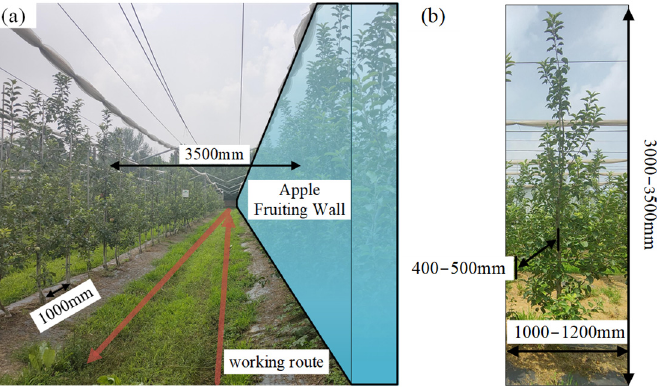
Figure 1. ( a ) Apple orchard with standard cultivation; ( b ) spindle-shaped